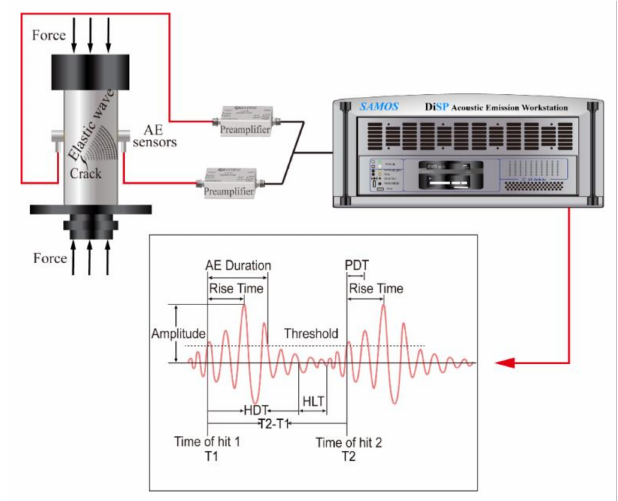
Figure 1. Schematic typical AE experiment and AE signals. The setting of the Peak Definition Time (PDT) ensures correct identification of the signal peak for rise time and peak amplitude